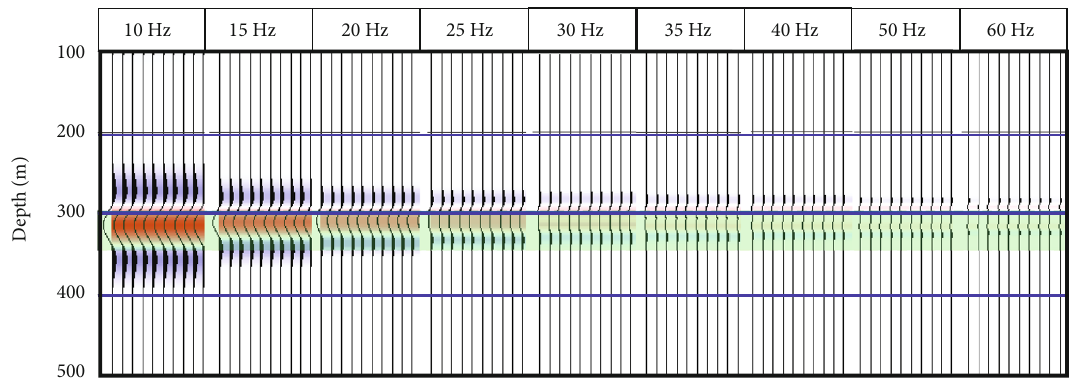
Figure 4: Re fl ection from a transition zone obtained by full-waveform modeling with the 0-phase Ricker wavelet of di ff erent dominant frequencies (see top of the fi gure). Transition zone thickness: 50 meters (green area), k = 0 : 8